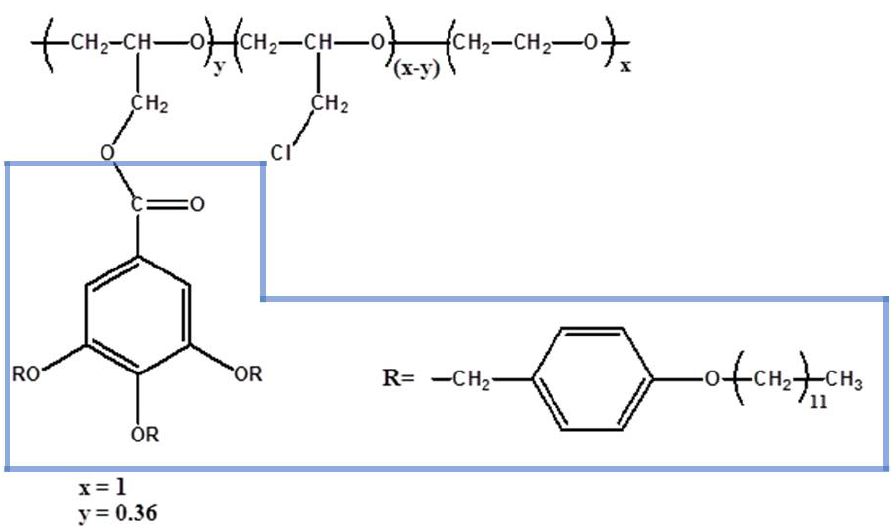
Figure 1. Chemical structure of CP36. In blue TAP group is marked.